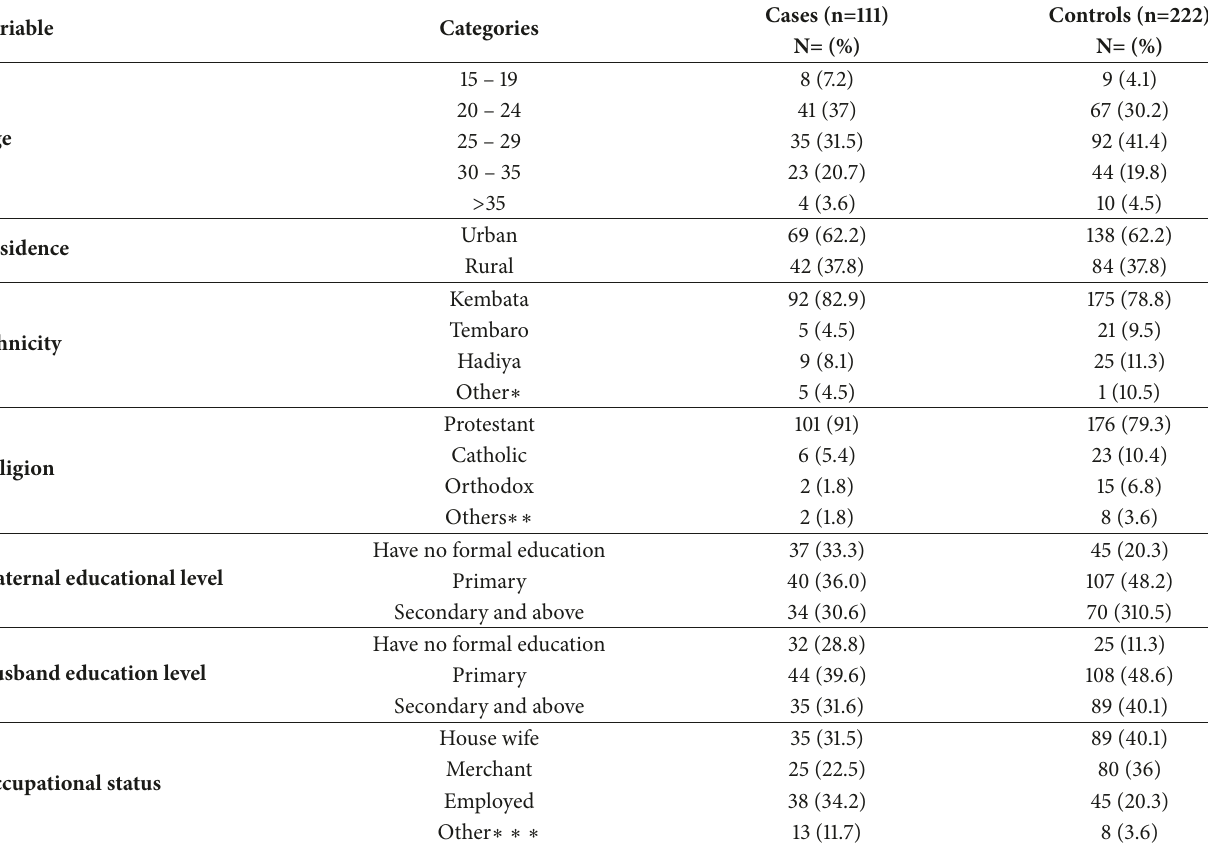
Table 1: Socio-demographic characteristics of pregnant mother attending ANC in public health facilities of Durame Town, February to May 2017.